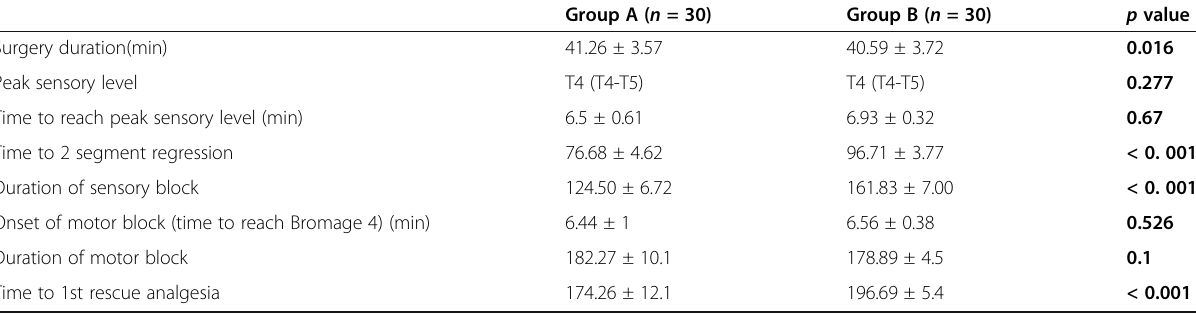
Table 8 Duration of